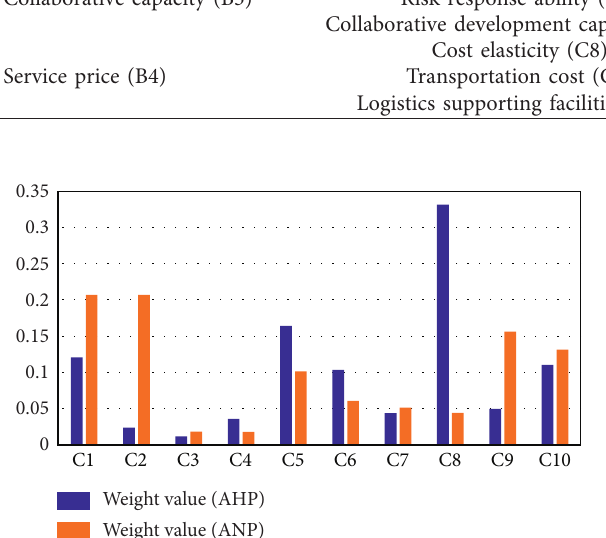
Figure 5: Network fitting comprehensive evaluation results.